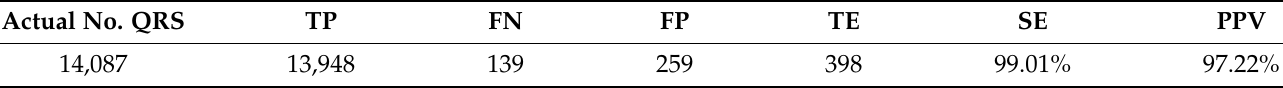
Table 1. Combined overall results of QRS-complex